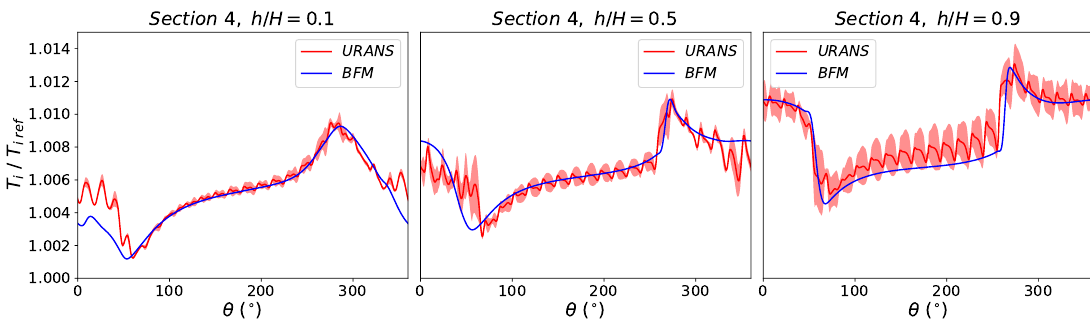
Figure 18. Azimuthal distribution of absolute total pressure in Section 4.